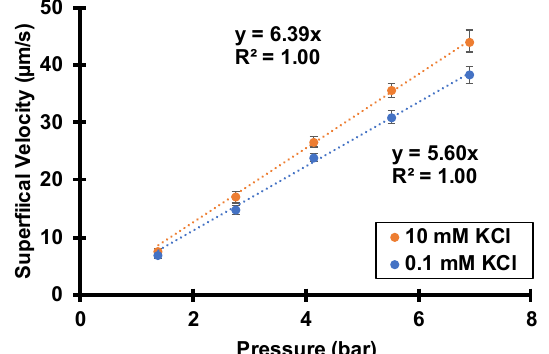
Figure 6. Superficial velocities of either 0.1 mM KCl or 10 mM KCl feed solutions passing through track-etched membranes (30 nm pores) at various transmembrane pressures. The membrane rotation rate is 1000 rpm.